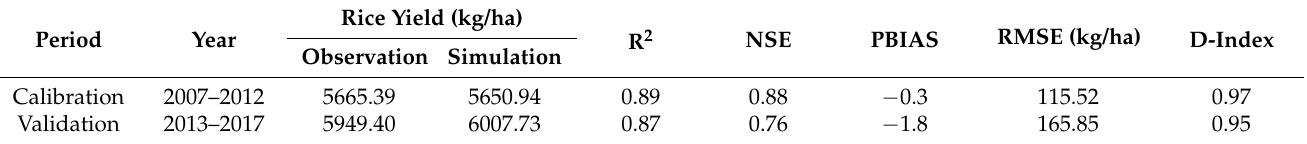
Figure 5. ( a ) Calibration and ( b ) validation of DSSAT-CERES-Rice. Table 3. DSSAT model performance for the Ciherang rice